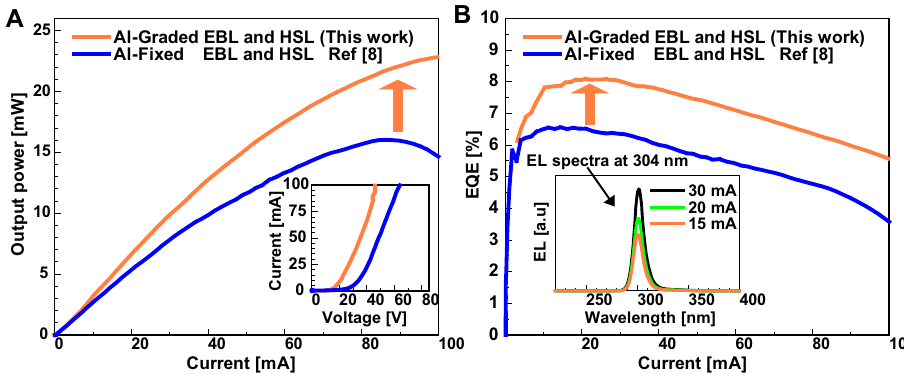
Figure 5. Performance evaluation of 304 nm-band ultraviolet-B (UVB) light-emitting diode (LED) (sample- COR02) and comparison with the previous UVB LED sample-HK02 (8): ( a ) I–L characteristics of improved UVB LED with big chip ( I-V characteristics are shown in the inset), ( b ) I–EQE characteristics (single peak EL emission spectra are also shown in the inset). Some part in ( a )–( b ) reproduced from ref. 8 . Copyright © 2020 American Chemical Society (ACS Applied Electronic